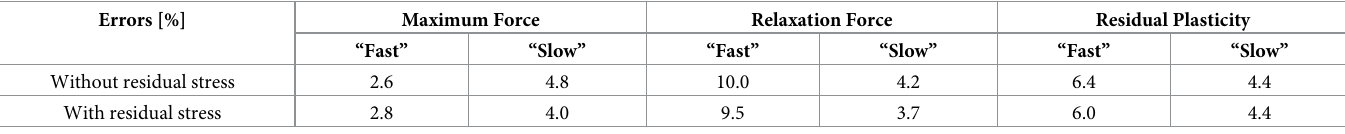
Table 1. Percentage errors obtained comparing the experimental data of tension testing with “fast” and “slow” protocols and computational results got at the end of the material tuning process, using a stress-free stent single unit model (line 1) and a single-unit with residual stresses (line 2). Errors